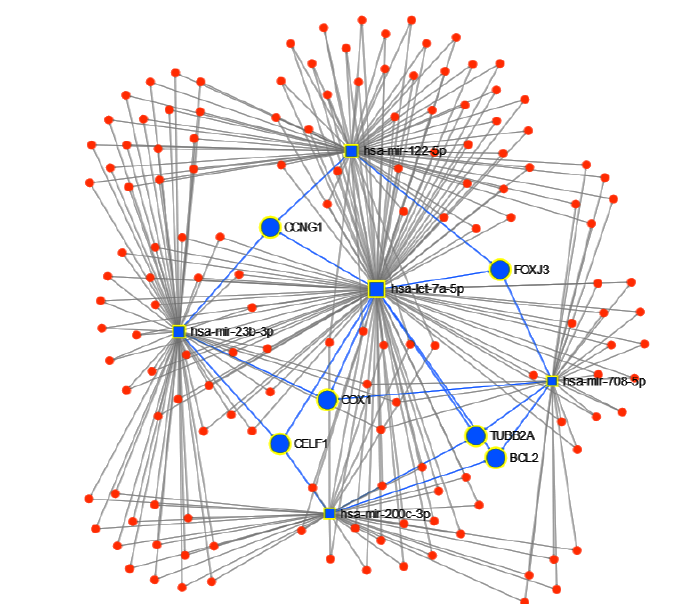
Figure 9. miRNET targeted genes analysis, showing genes targeted by at least 3 of the 5 miRNAs to